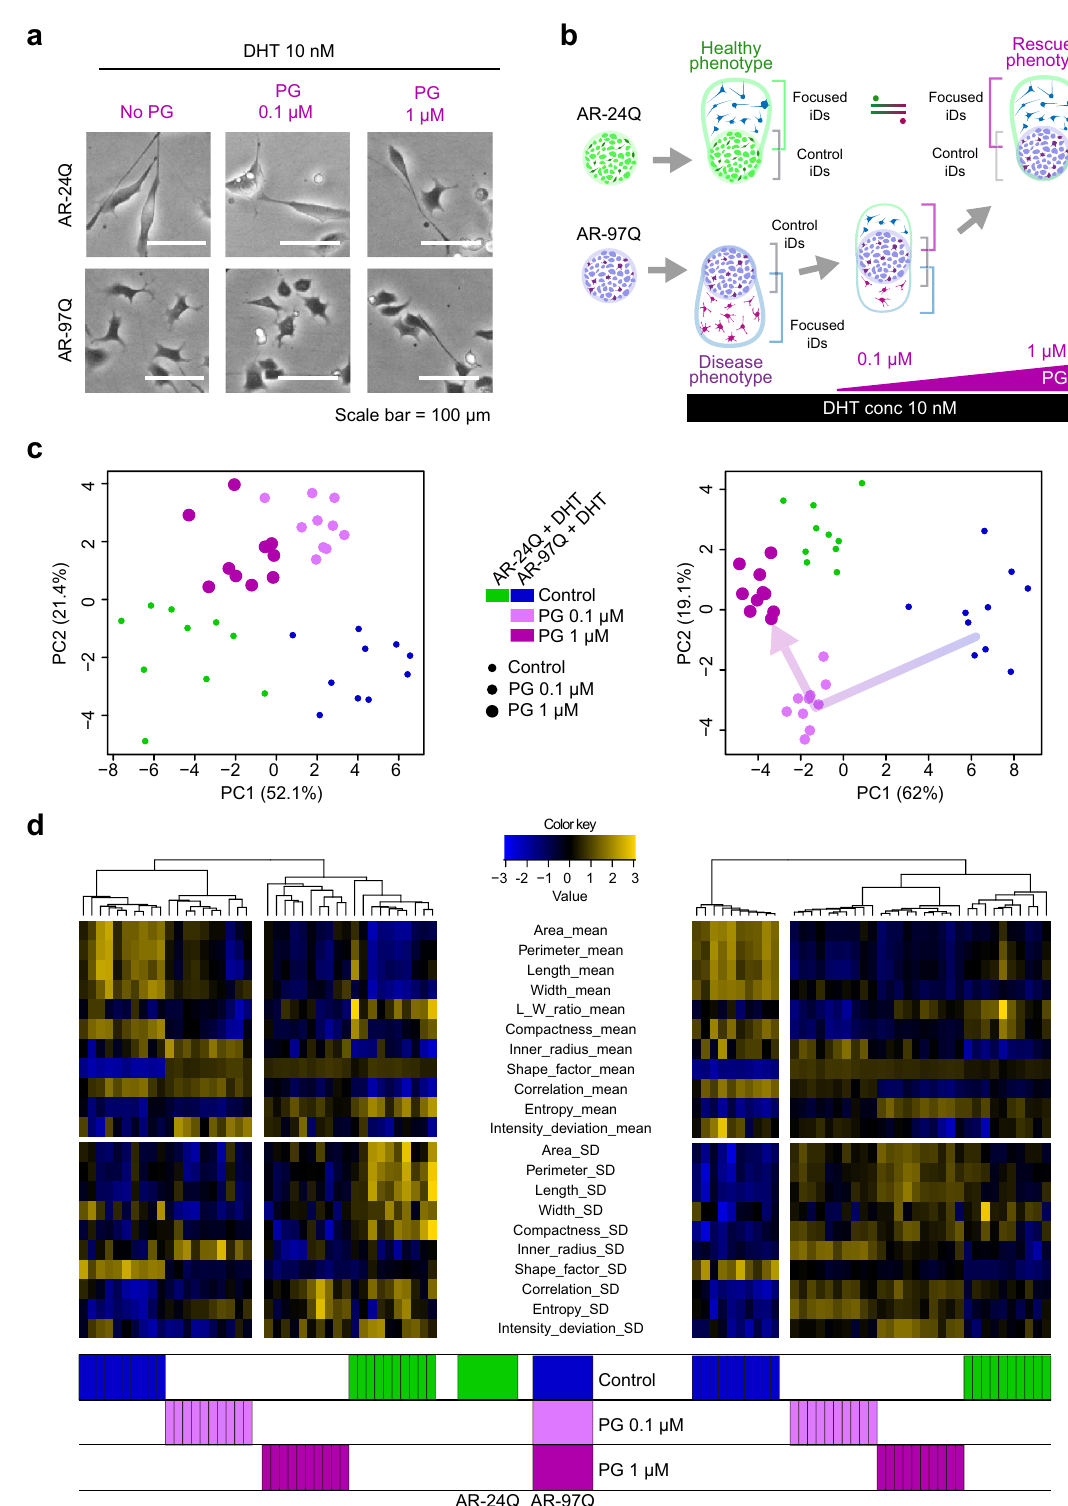
Figure 4. Evaluation of phenotypic responses of dihydrotestosterone (DHT)-stimulated model cells treated with pioglitazone (PG). ( a ) Representative images depicting the effect of PG on the (DHT)-stimulated model cells. ( b ) Schematic illustration of in silico featured-objects concentrated by anomaly discrimination from unit space (in silico FOCUS) analysis used to compare the phenotypic response of the model cells to PG. ( c , d ) Principal component analysis (PCA) and clustering of population data (pDs) with bootstrap (b-pDs) (left) and pDs from in silico FOCUS (focused pDs) (right). PCA of focused pDs; the arrow indicates the dose-dependent morphological rescue effect of PG. All illustrations created by Adobe Illustrator 24.1.1 (https:// www. adobe. com/ jp/ produ cts/ illus trator.